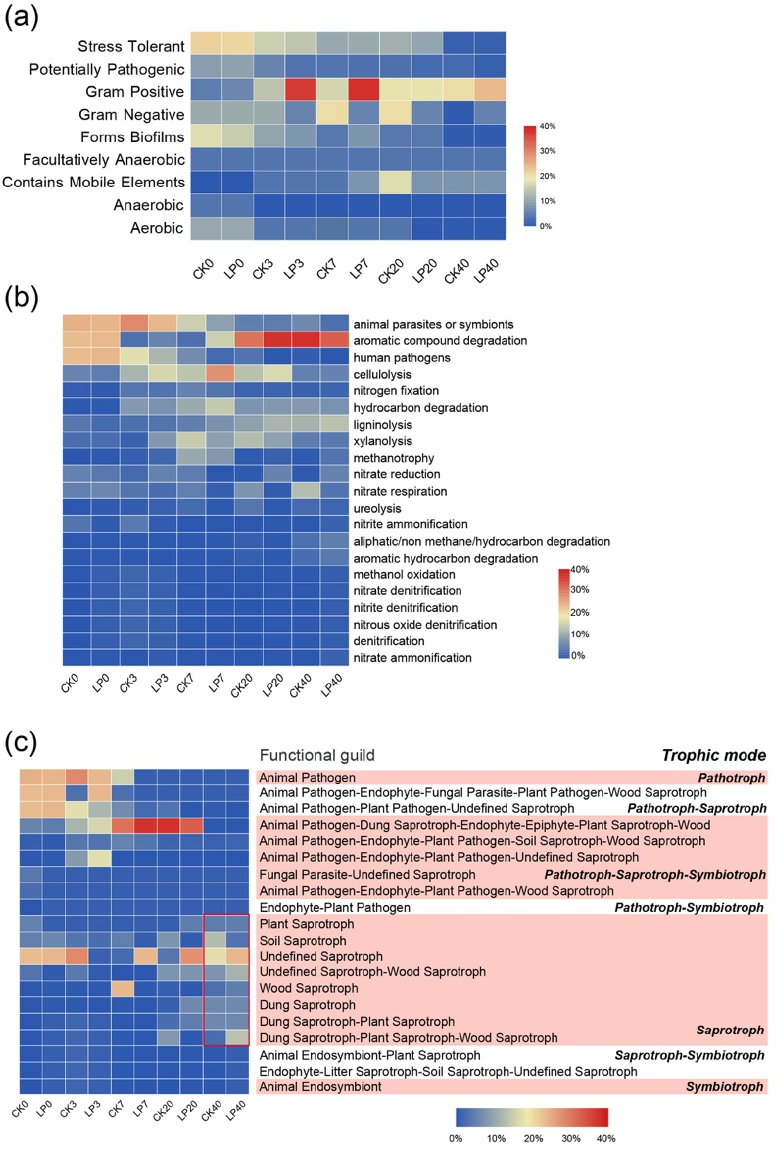
Figure 4. Heatmaps of the dynamics of microbial function in the compost with and without inocu- lation. ( a ) The bacterial phenotypes based on BugBase. ( b ) Bacterial function prediction based on FAPROTAX. ( c ) The fungal trophic mode and functional guild based on FUNGuild. Red line were the Guilds in final composts.